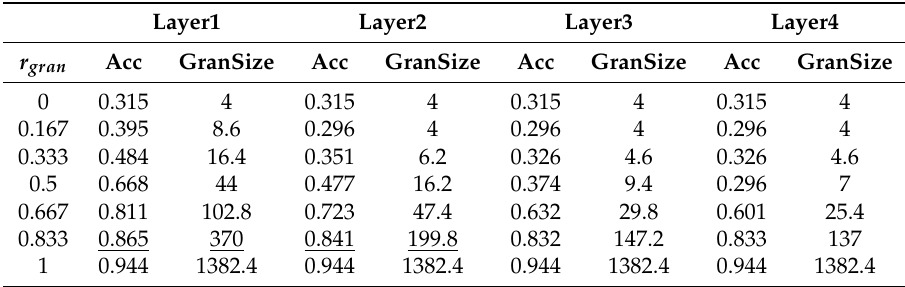
Table 17. CV-5; Result of experiments for multi-layer c-d granulation with use of kNN classifier; data set Car evaluation; r gran = Granulation radius, Acc = Average accuracy for the considered layer, TRNsize The mean size of granular decision system for the considered